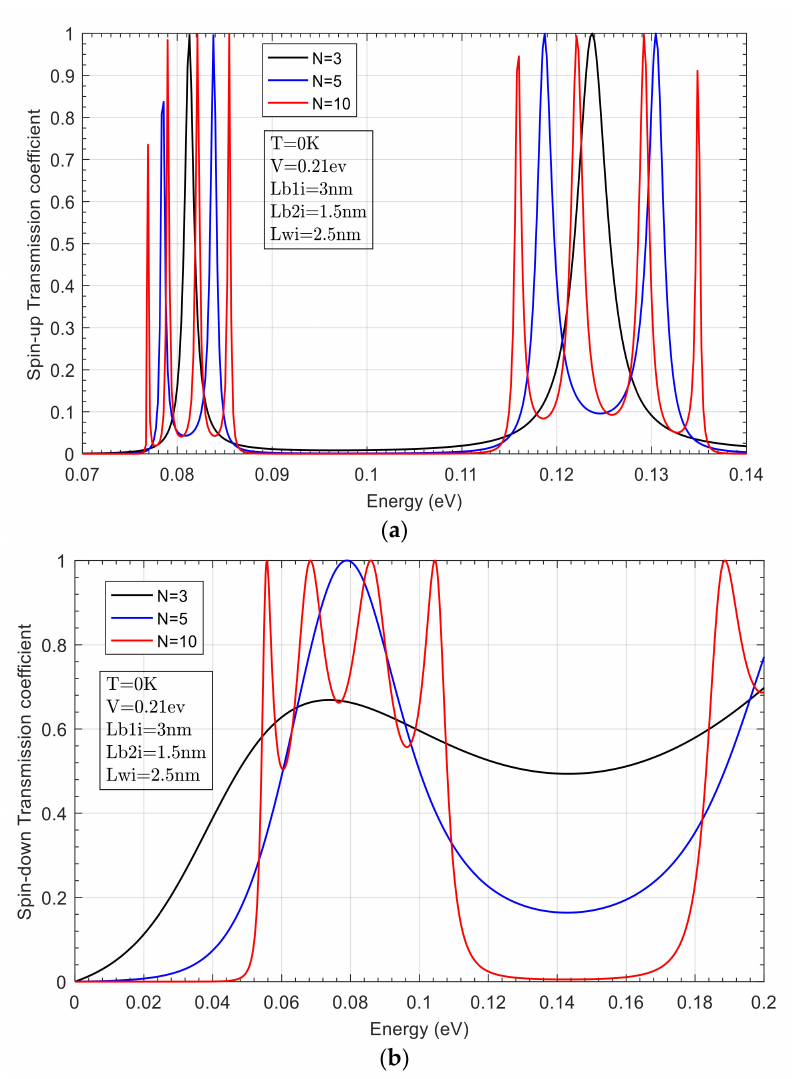
Figure 7. ( a ): The transmission coefficient of spin-up holes as a function of incident energy for three barrier numbers (N = 3, 5, and 10). T = 0 K. ( b ): The transmission coefficient of spin-up holes as a function of incident energy for three barrier numbers (N = 3, 5, and 10). T = 0